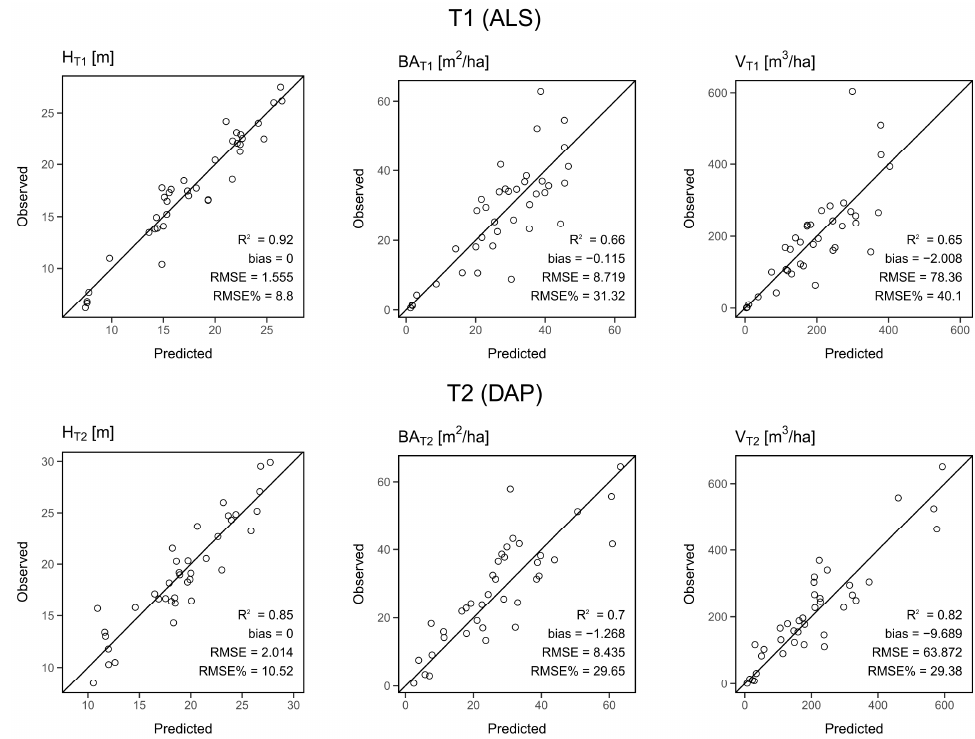
Figure 2. Observed vs predicted values for the three modeled stand attributes: Top height (H), basal area (BA), and total volume (V). Stand attributes modeled using airborne laser scanning (ALS) data at Time 1 (T1) and digital aerial photogrammetry (DAP) data at Time 2 (T2). Table 2. Predictive models for top height (H), basal area (BA), total plot volume (V). Dependent variables denoted with T1 were modeled using ALS data acquired at T1 (2006–2008), while T2 variables were modeled using DAP data from T2 (2015). Predictor variables used in these models included the 20th percentile of point heights (P20), the 95th percentile of point heights (P95), the proportion of points above 5 m (PERC_ABOVE_5), the standard deviation of point heights (SD), and the kurtosis of point heights (KURT). Dependent Variable